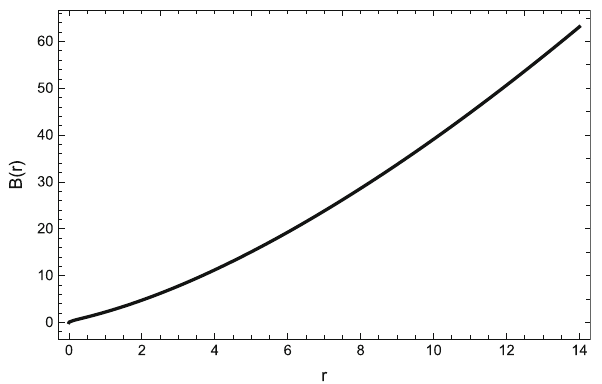
Fig. 3 Metric coefficient A ( r ) as a function of the radial coordinate r for the case of w = 1 / 5 with α = 2, f 0 = 1 / 3, a 0 = 1, K 0 = 1, k 0 = k 1 = 1, I 3 = − 1 and I 2 = I 4 = 1